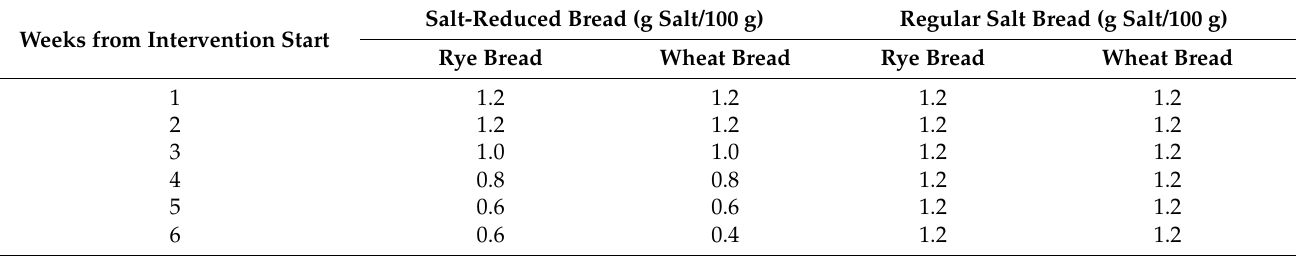
Table 1. Salt content in study bread products. Weeks from Intervention